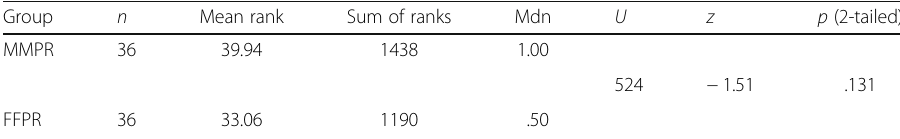
Table 5 Results of the Mann-Whitney U test on participants ’ writing development Group n Mean rank Sum of ranks Mdn U z p (2-tailed) MMPR